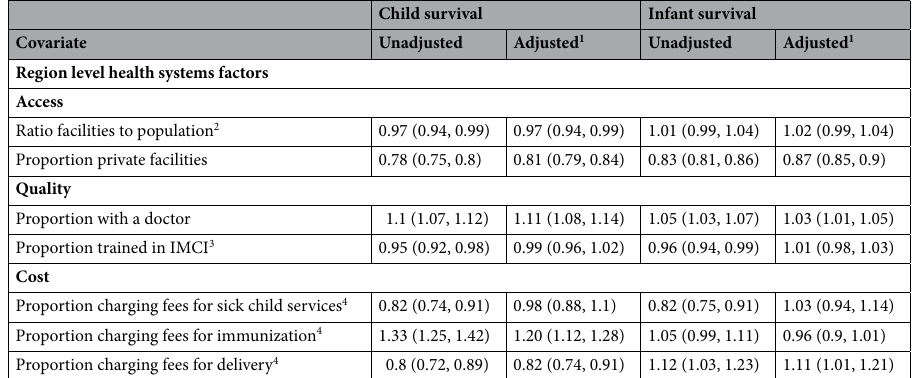
Table 3. Unadjusted and adjusted estimated hazard ratios (95% Confidence interval) for the effect of health system characteristics on time to death for infants and children. These estimates are exponentiated coefficients from accelerated failure time models and approximate the hazard ratio. Full model results including all covariates is presented in Supplemental Table 3. 1 Adjusted for child-level (male, birth order and birth year), maternal-level (maternal age, education and marital status) and household-level (urban, wealth score) factors. 2 The ratio of facilities in a region divided by the ratio of the population in the same region. 3 Proportion of health staff trained in Integrated Management of Childhood Illness per facility averaged across all facilities in the region. 4 Proportion of facilities in a region charging any fees for these types of services, including for consultation, registration, health card, drugs, vaccines, syringes or